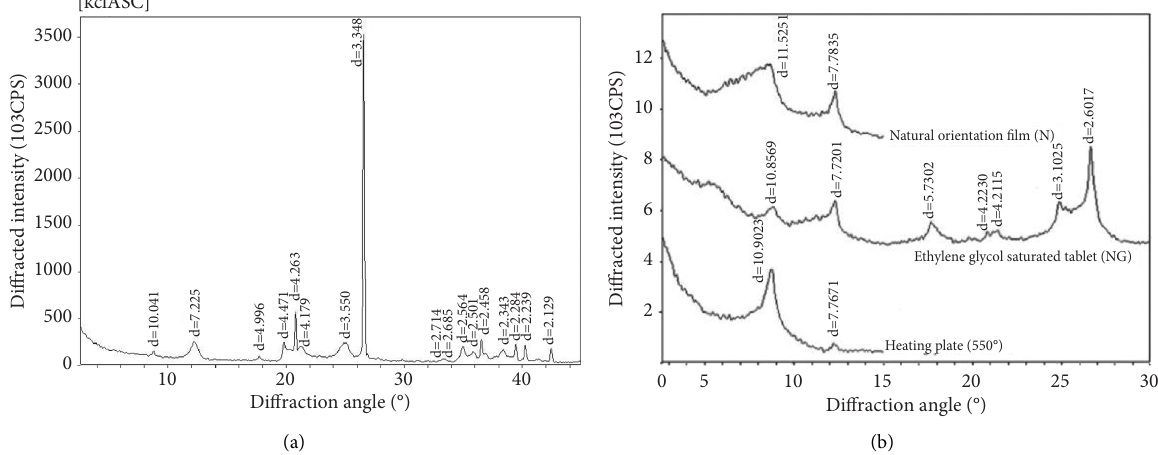
Figure 1: (a) X-ray diffraction pattern of nonclay minerals; (b) X-ray diffraction pattern of the relative content of clay minerals.